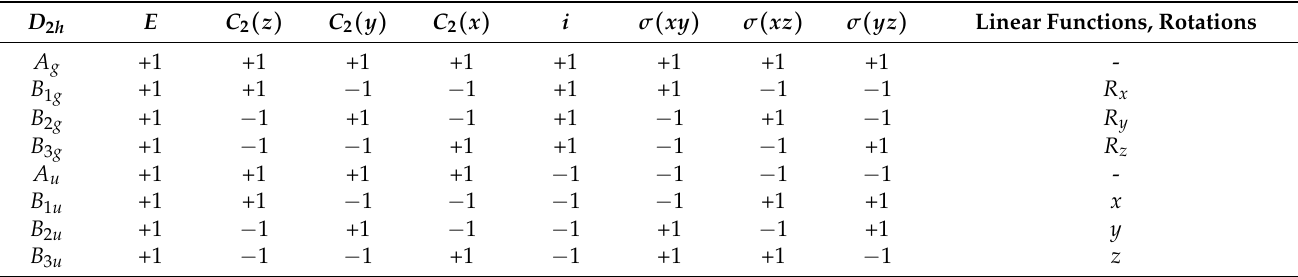
Table A4. Character table for D 2 h point group.